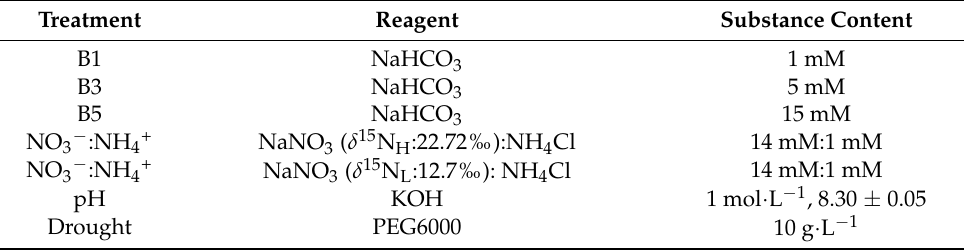
Table 1. Different bicarbonate treatments to Ov and Bn in simulated karst habitats. Treatment Reagent Substance Content B1 NaHCO